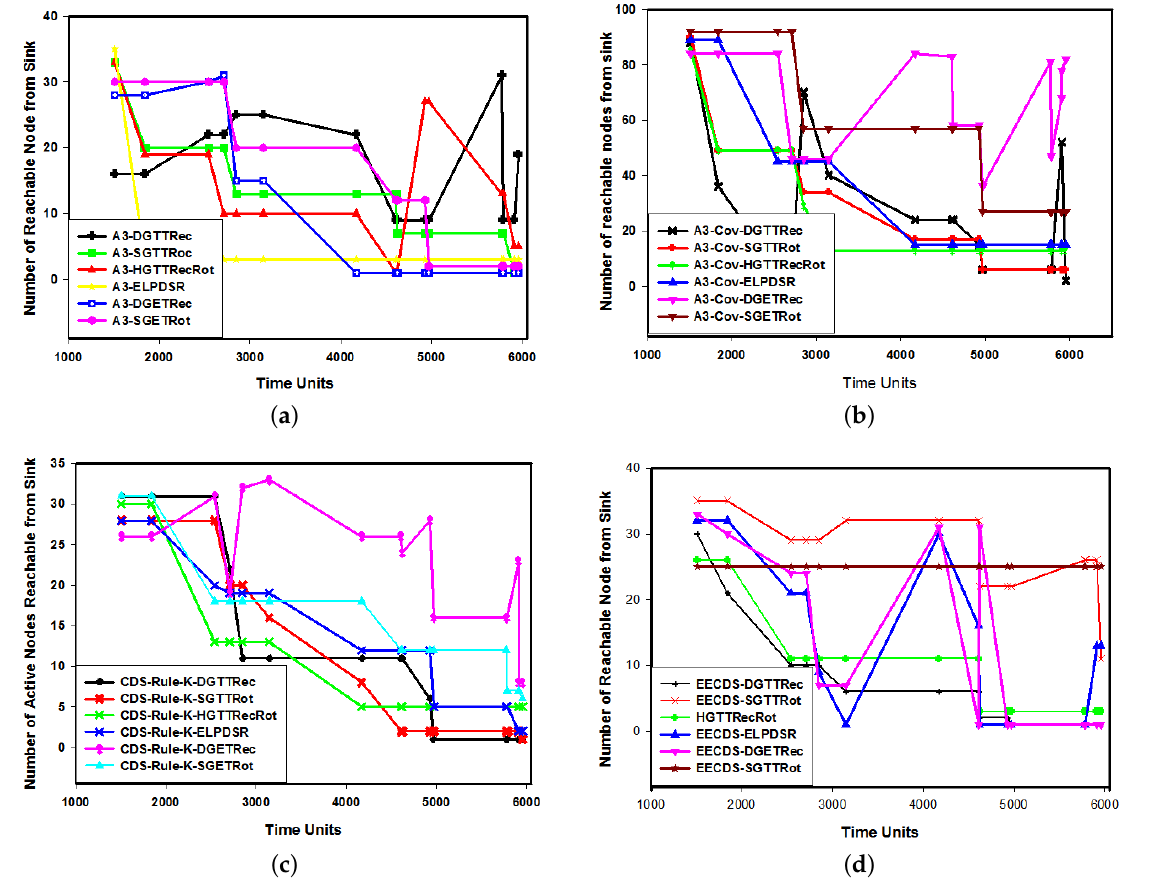
Figure 7. Topology maintenance for number of active nodes reachable from sink using ( a ) A3, ( b ) A3-Cov, ( c ) CDS-Rule-K and ( d ) EECDS